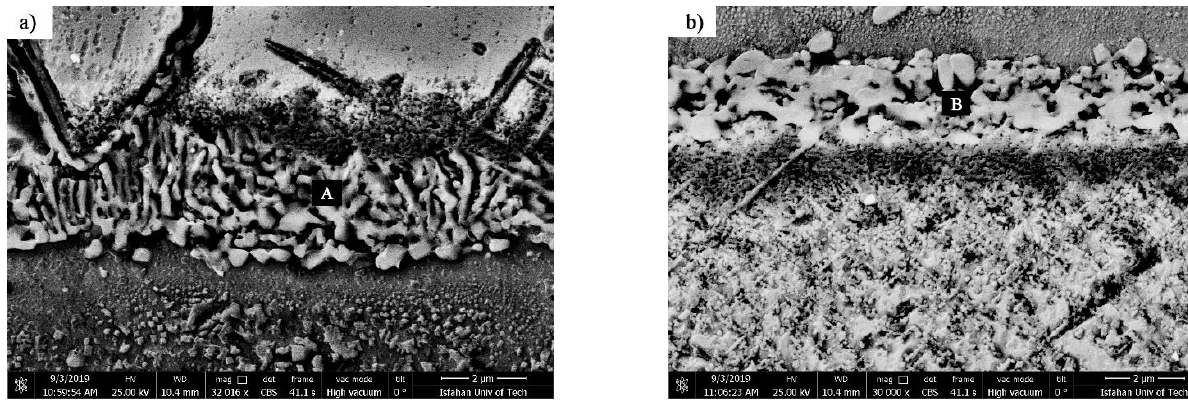
Figure 17. SEM micrographs of the diffusion-affected zone on the side of the ( a ) FSX-414 and ( b ) X-45 with the 1150 °C/10 min bonding condition.